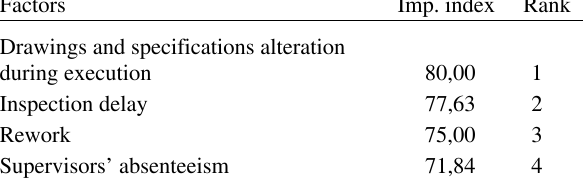
Table 6. Ranking factors under supervision group